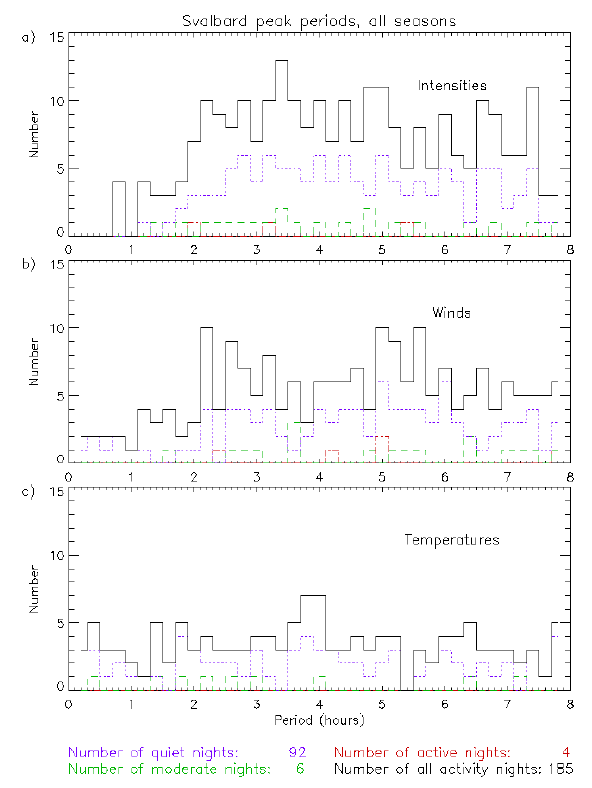
Fig. 11. Histogram of gravity wave periods for all Svalbard data (2000–2006) at all activity levels: (a) intensities, (b) winds, and (c) temperatures.